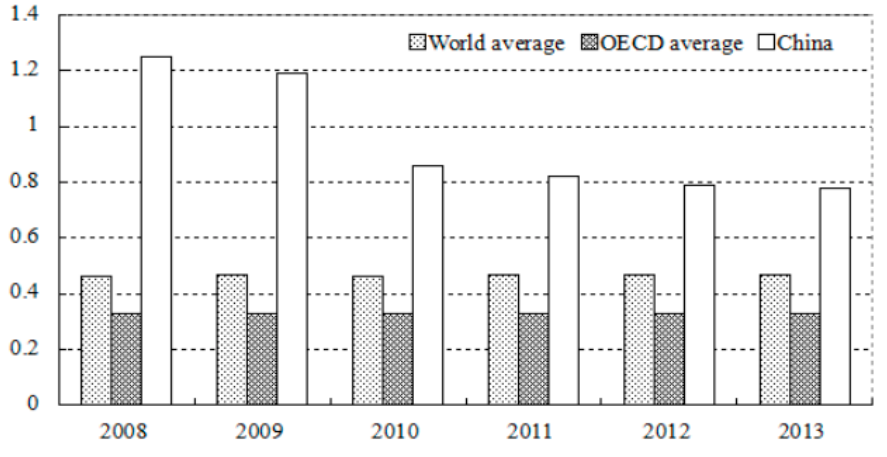
Figure 10. Comparison of GDP electricity intensity